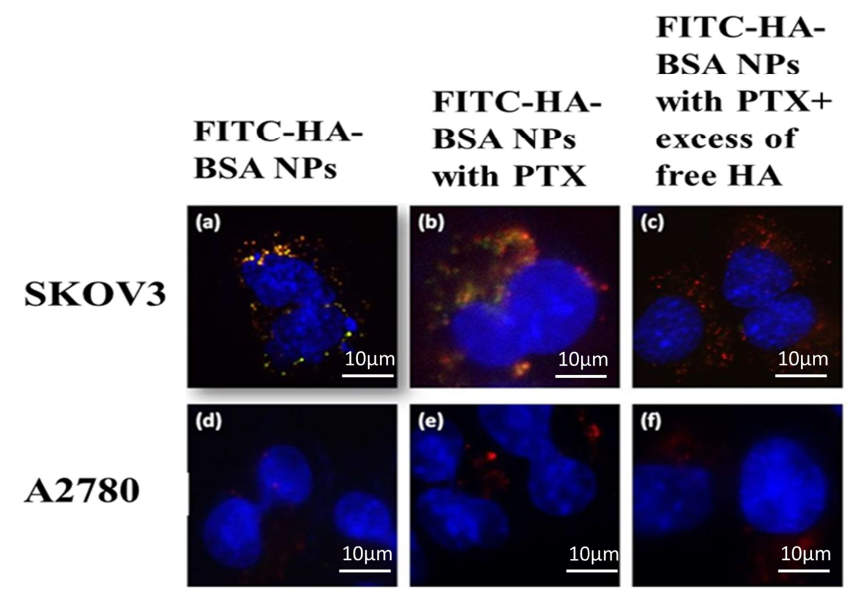
Figure 7. SKOV3 (CD44+) and A2780 cells (CD44−) were incubated with 3 different NPs: ( a , d ) FITC-HA-BSA (20µM). ( b , e ) PTX encapsulated within FITC-HA-BSA (PTX: BSA at a molar ratio of 2:1). ( c , f ) PTX encapsulated within FITC-HA-BSA + excess free HA (100-fold higher concentration